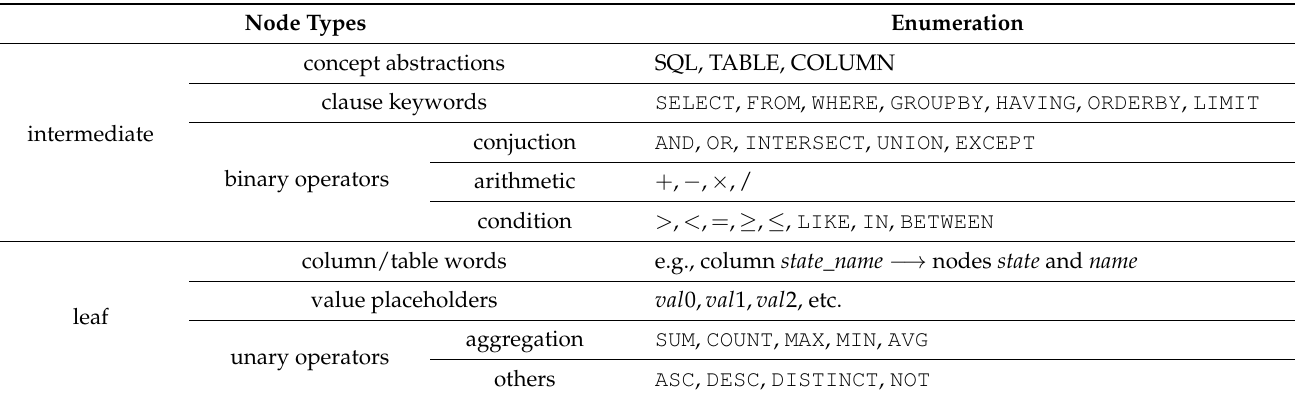
Figure 3. SQL Tree construction procedure. ( a ) is clause level; ( b ) is schema level; ( c ) is token level. Table 1. Enumeration or examples of all types of